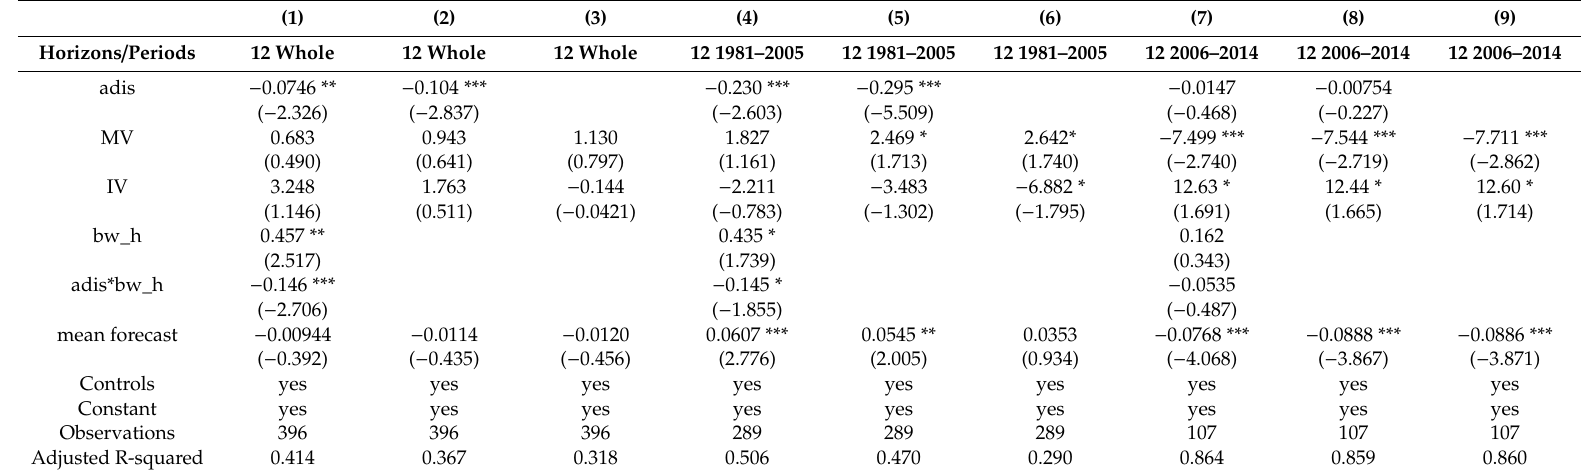
Table 6. Investor sentiment and the dispersion e ff